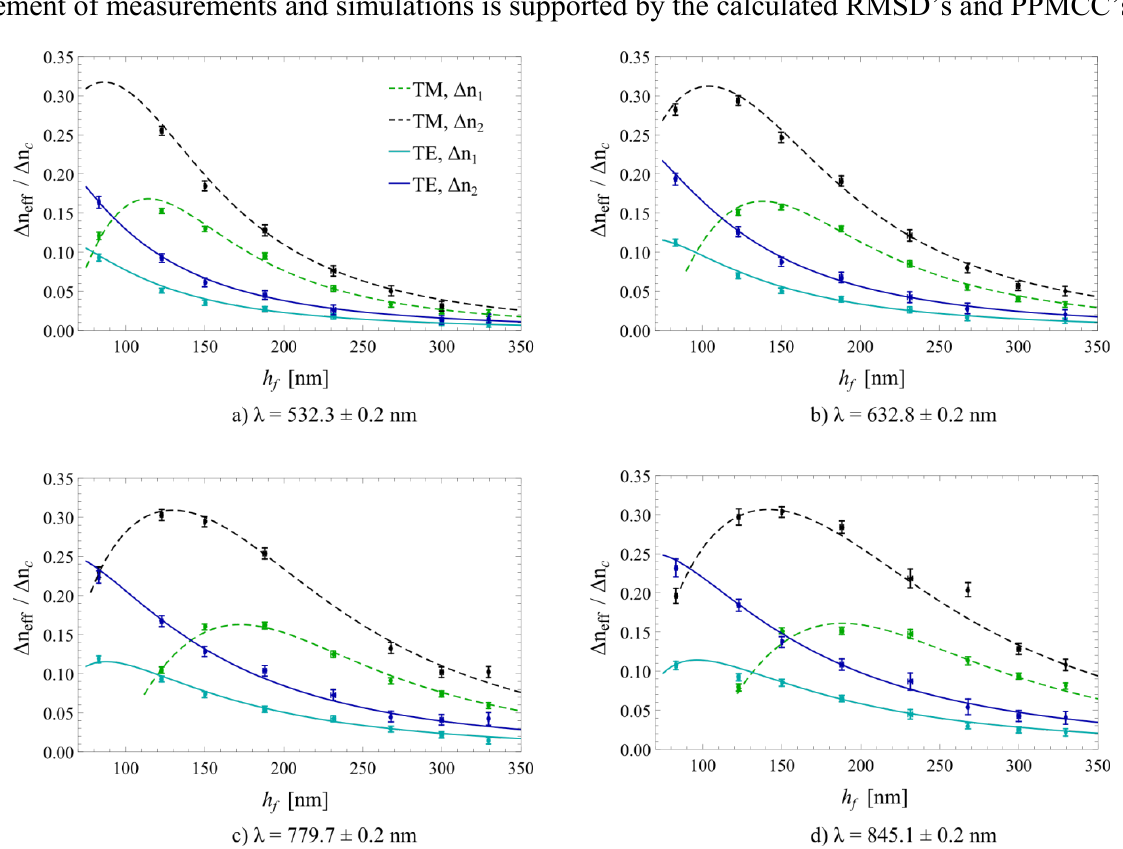
Figure 7. Measured (marks) and calculated sensitivities (lines) for transverse magnetic (TM) and transverse electric (TE) polarization at the four investigated wavelengths of the incident light. All error bars (standard deviations of all measured values) were plotted but some are barely discernible due to their small